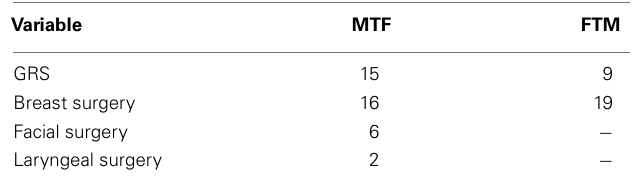
Table 3 | Surgical procedures in gender dysphoria patients